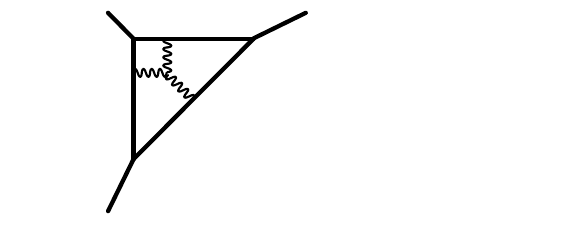
Figure 6 . String junction generating BPS particle with spin ( j